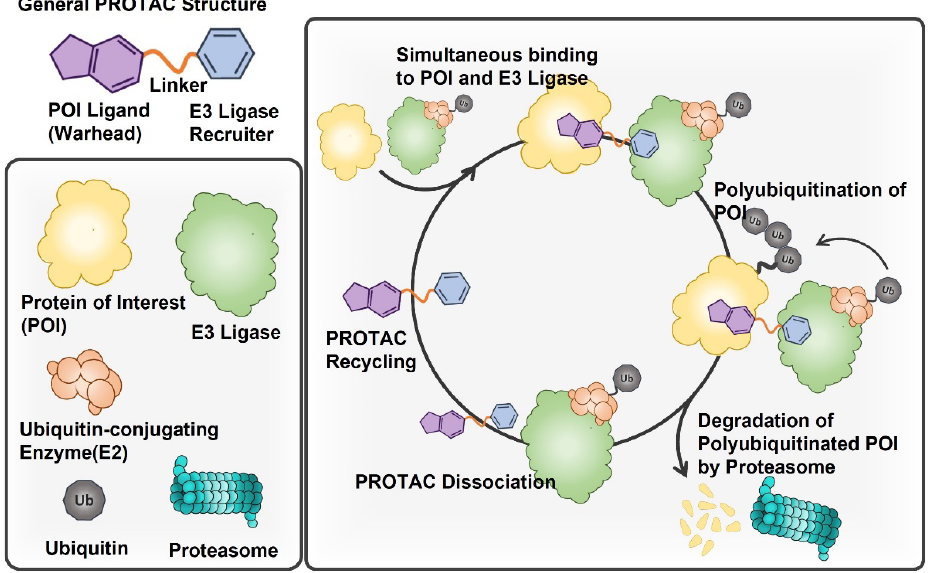
Figure 1. Structure and specific MOA of PROTACs. PROTAC has a structure in which two ligands for E3 ligases and POI are coupled to each other through a linker. It simultaneously anchors both POIs and E3 ligases, letting them approach each other. E3 ligases form a complex with the E2 enzyme and induce the polyubiquitination of adjacent POIs. Proteasome recognizes polyubiquitinated POIs and degrades them into amino acids. The dissociated PROTAC molecule can participate in another degradation cycle of POI.